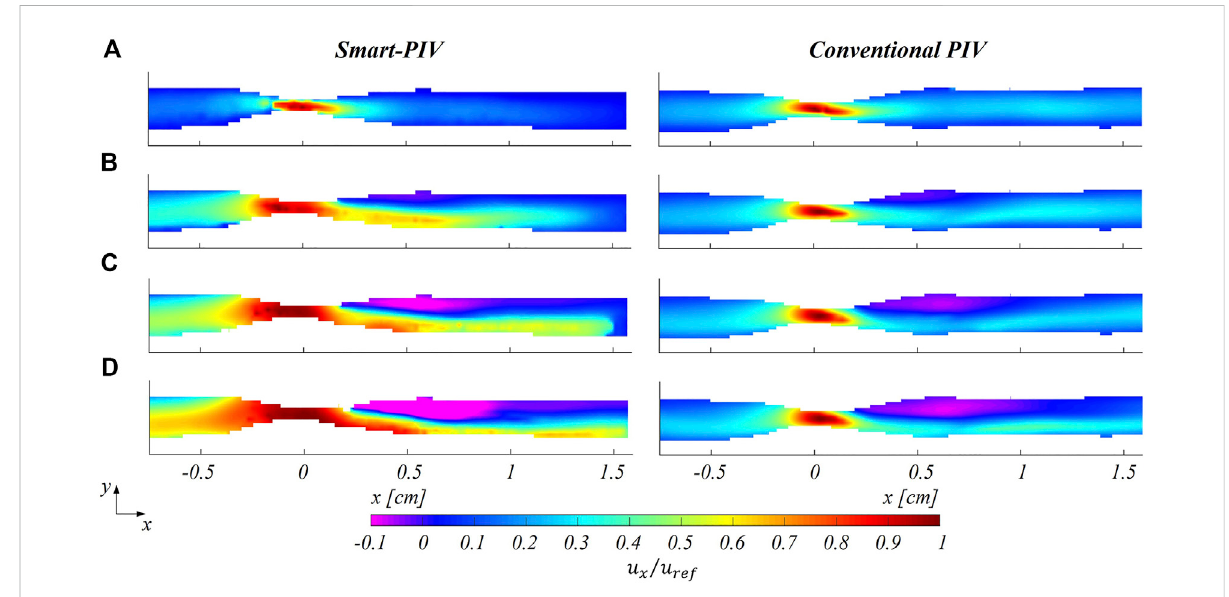
FIGURE 8 Normalized mean streamwise velocity contours for smart (left panel) and conventional (right panel) PIV at four different fl ow regimes: (A) Re inflow =21; (B) Re inflow =64; (C) Re inflow =107; (D) Re inflow =171forthestenosedLADphantom.Themeanstream-wisevelocity( u x )isnormalizedto the maximum velocity ( u ref